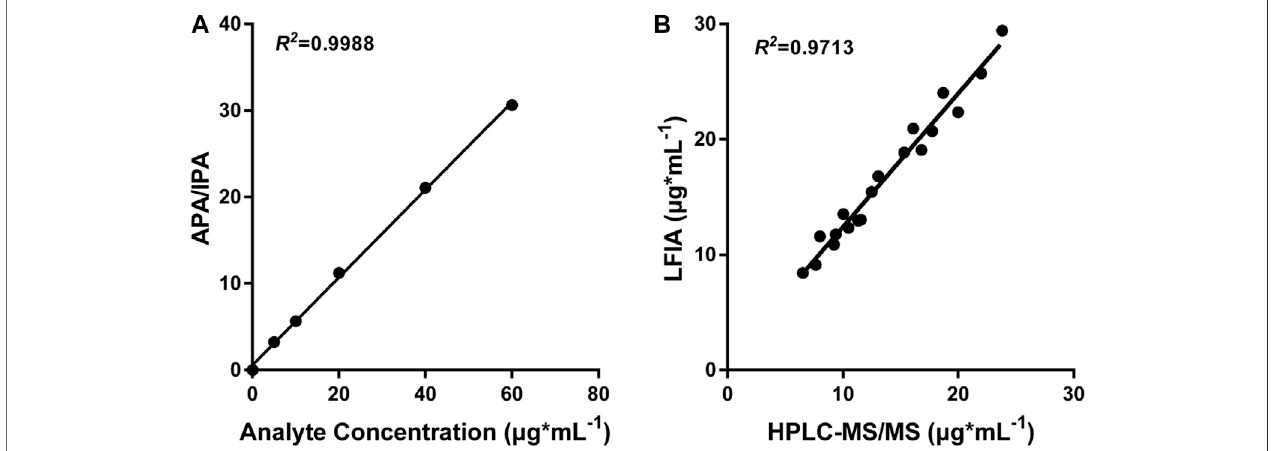
FIGURE 6 | LC-MS/MS analysis and comparison with CN-EUs-based LFIA strips. (A) LC-MS/MS calibration curve of VAN according to the following VAN standards:0,5,10,20,40,and60 μ g*ml − 1 .APA (cid:1) analytepeakarea,IPA (cid:1) ISpeakarea. (B) LinearcorrelationbetweentheproposedCN-EUs-basedLFIAandLC-MS/ MS ( R 2 (cid:1)